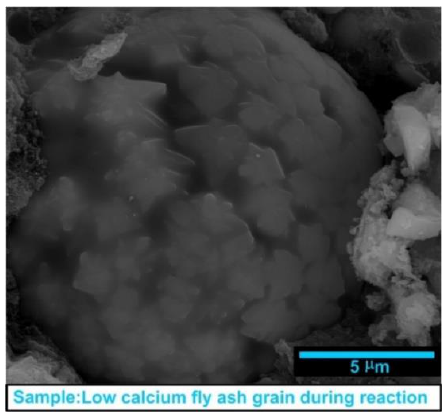
Figure 1. Exemplary of a fine low calcium fly ash (LCFA) grain during a pozzolanic reaction.